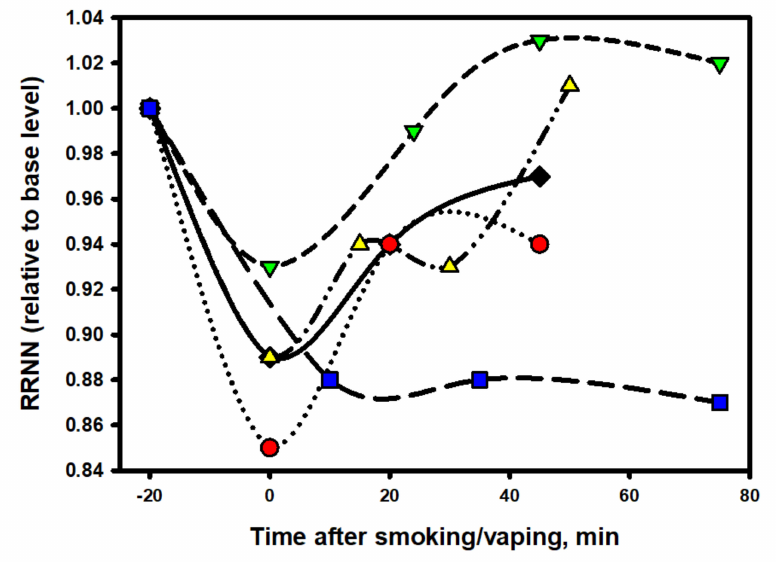
Figure 8. Dynamics of RR intervals after the use of various nicotine-containing products by a smoking volunteer.